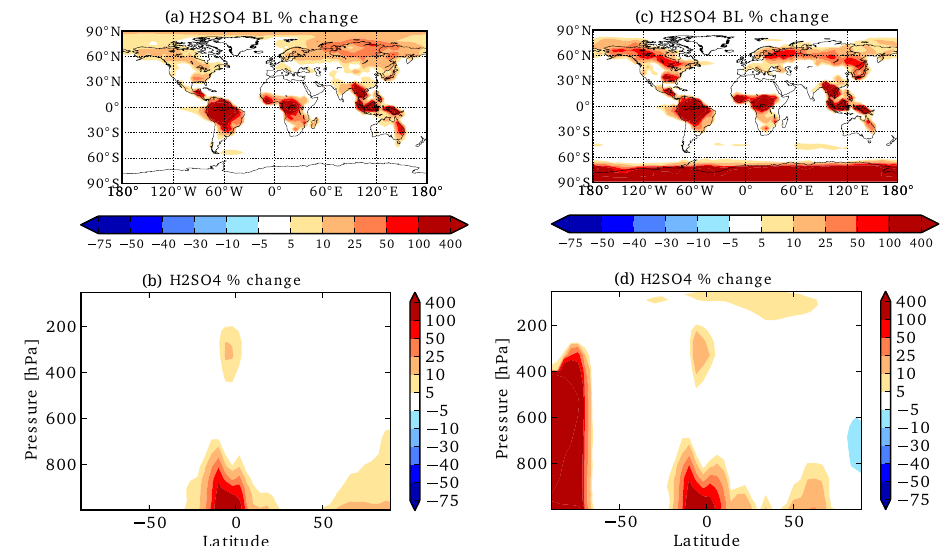
Fig. 3. Percent change in gas-phase H 2 SO 4 concentration due to the addition of the CI+SO 2 chemistry (BASE-CI-BASE). The left column ( a and b ) is annual-mean values, and the right column ( c and d ) is for July. The top panels ( a and c ) show the boundary-layer values, and the bottom panels ( b and d ) show zonal-mean values.